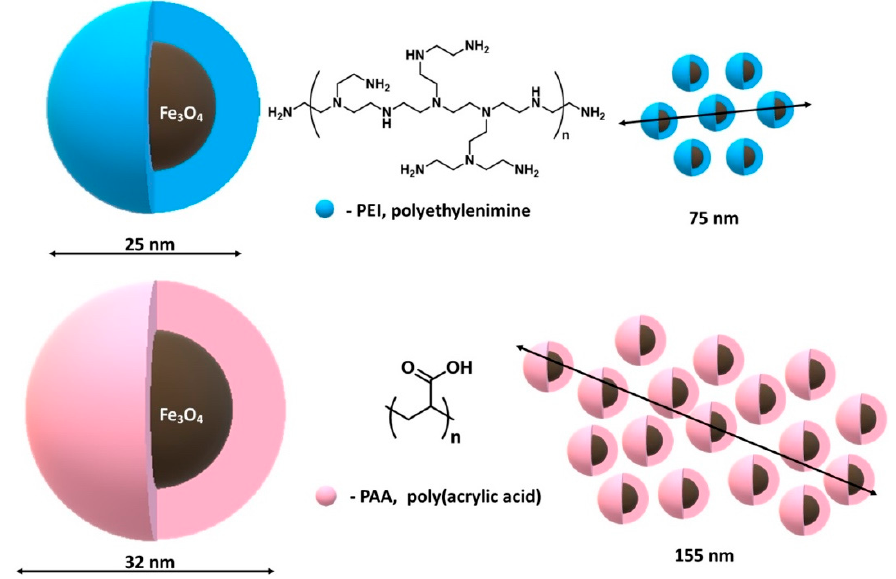
Figure 12. Sketched evolution of the particle agglomeration process for the MNPs when in their as-prepared suspension in water. as-prepared suspension in